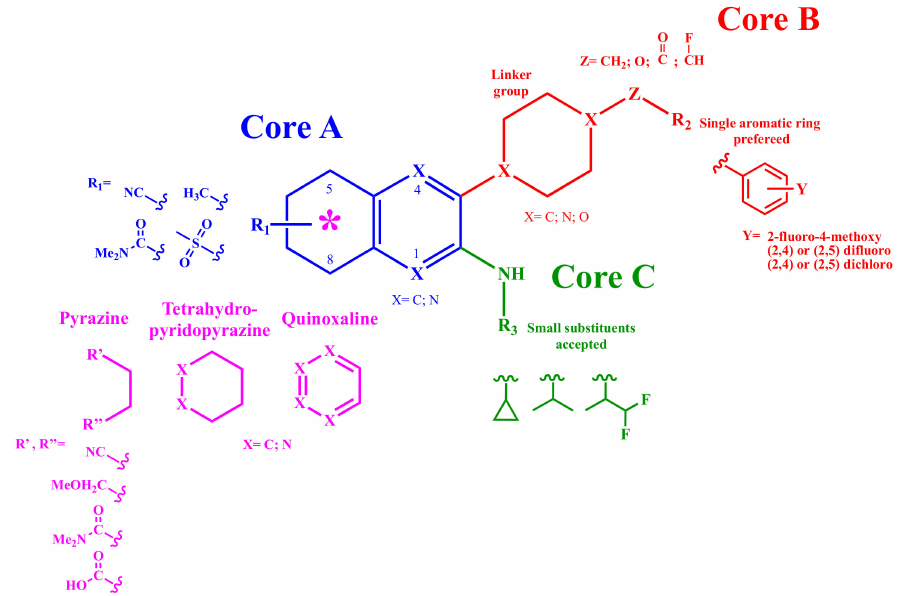
Figure 5. Structure activity relationship (SAR) analysis of Pyrazine analogs. The scheme represents selected examples covered by the